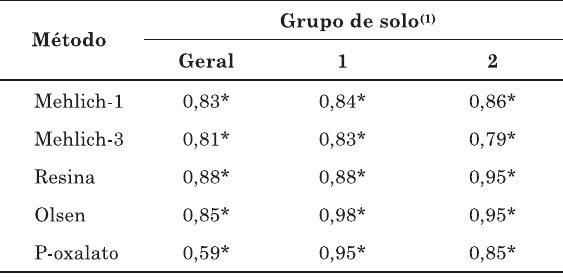
Figura 3. Relação entre os teores de fósforo extraídos por oxalato e as quantidades de fósforo acumulado pelo arroz nas amostras dos solos: Planossolo, Gleissolo, Luvissolo, Vertissolo e Chernossolo, nas três doses de fósforo (0; 19,6 e 39,3 mg kg -1 de P